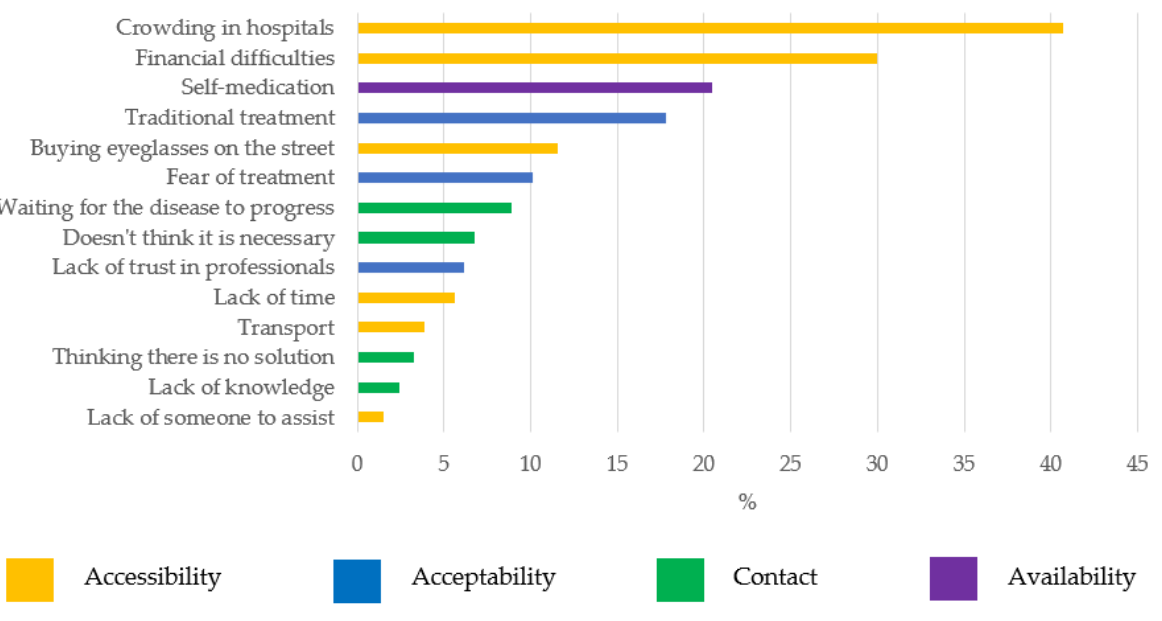
Tanahashi Figure 1. Percentage of mentions of each barrier by respondents. Classification according to the Tanahashi model.